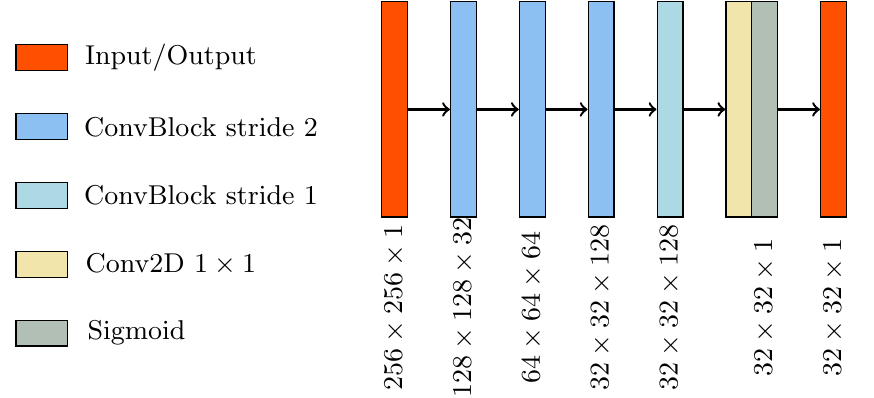
Figure 3. Schematic of the discriminator network